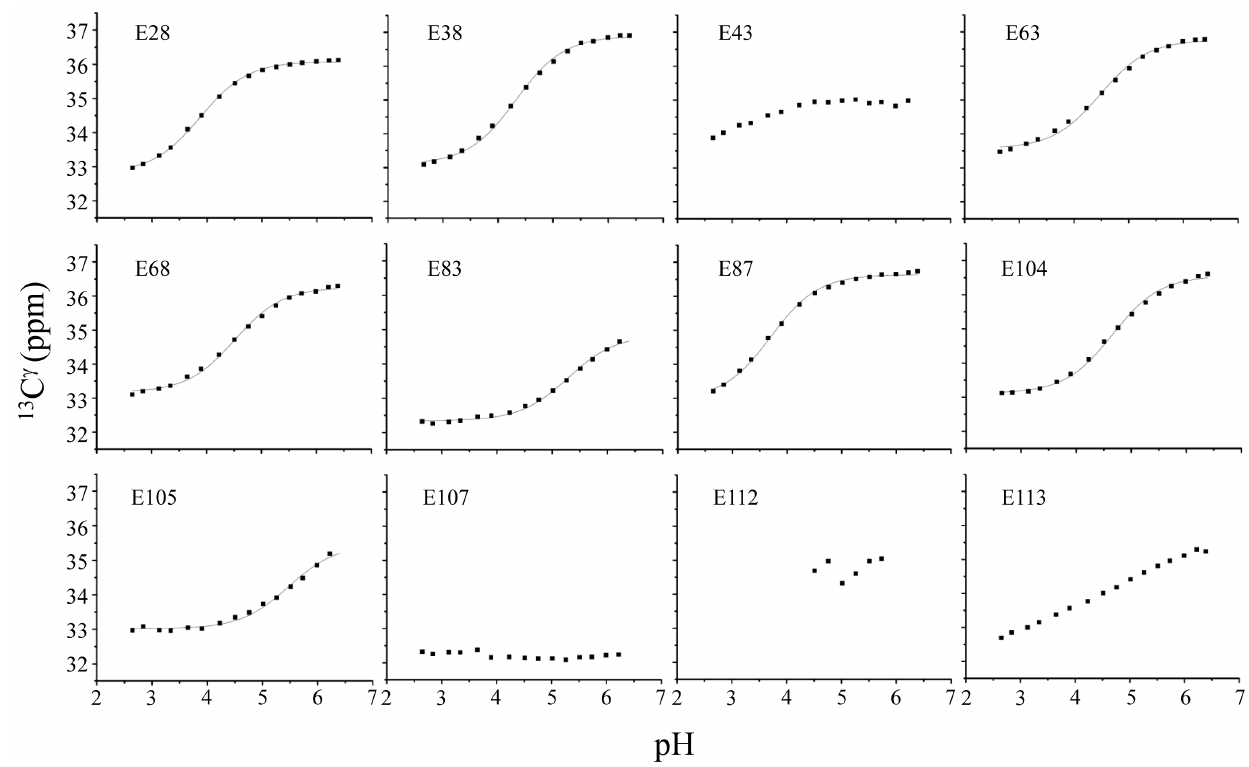
Figure 3. The pH-dependent c - 13 C chemical shifts for all of the glutamate residues in the ESD. The pKa values were determined by fitting the data using the Henderson-Hasselbach equation (solid line). The pKa values are listed in Table 1.